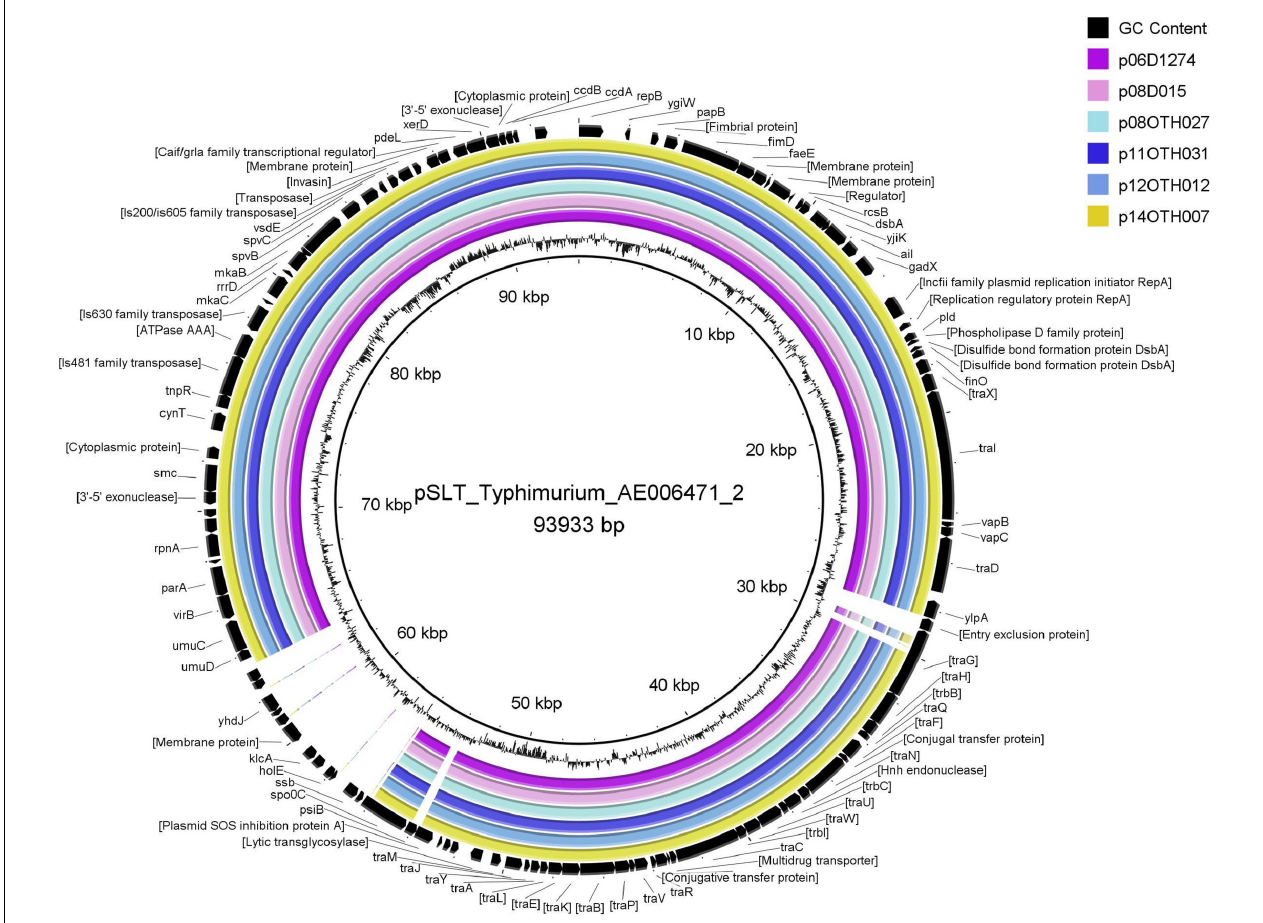
FIGURE 3 | BRIG diagram comparing unusual S . Enteritidis plasmid sequences with that of the reference plasmid pSLT. Colored rings represent 100% similarity to the reference